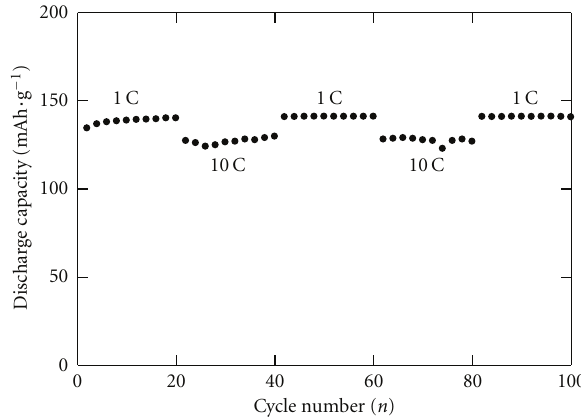
Figure 6: Discharge e ffi ciency of LiNi 0 . 5 Mn 1 . 5 O 4 cathode at rate indicated.